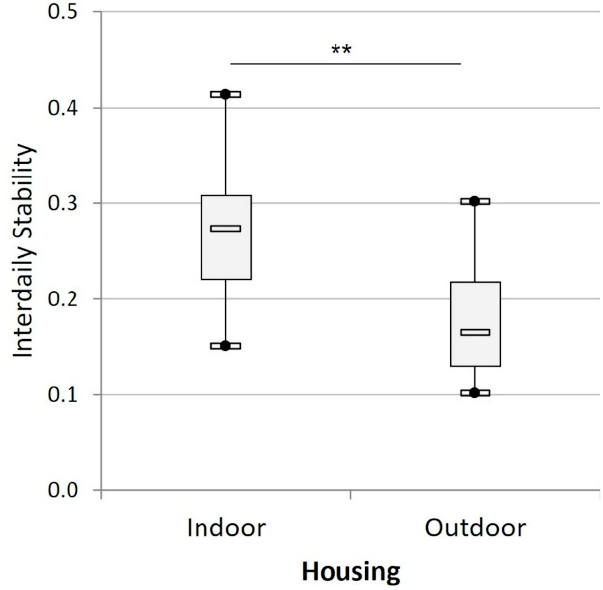
Figure 8. Mean interdaily stability of the feeding rhythm of the cats according to their housing con- dition (indoors (n = 15) versus outdoors (n = 8)). (**) indicates p < 0.01. condition (indoors (n = 15) versus outdoors (n = 8)). (**) indicates p <